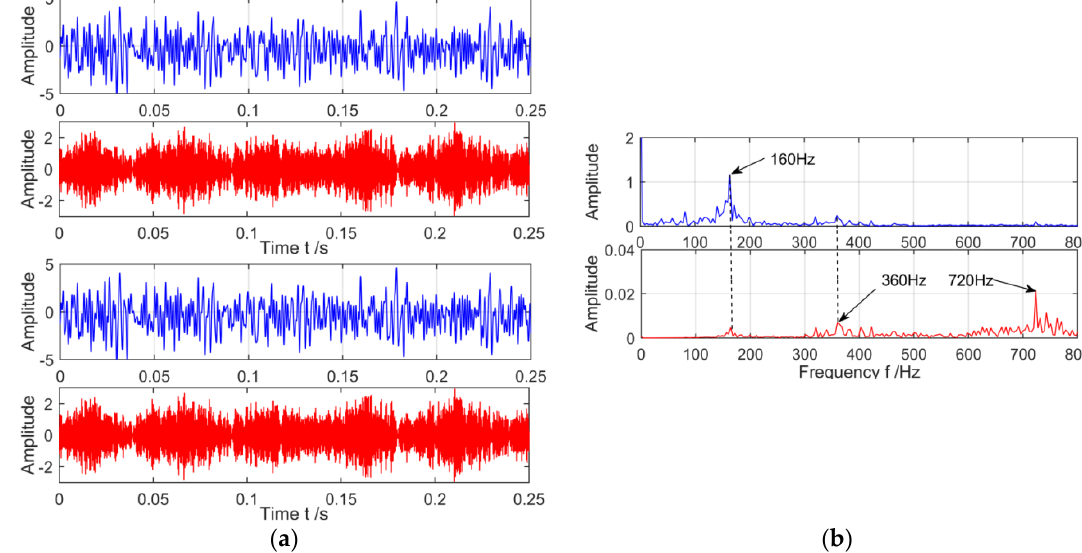
Figure 12. The spectrum of IMFs after VMD decomposition and its corresponding spectrum. ( a ) Time domain of IMFs after VMD of vibration signal; and ( b ) The spectrum corresponding to each layer of IMF.